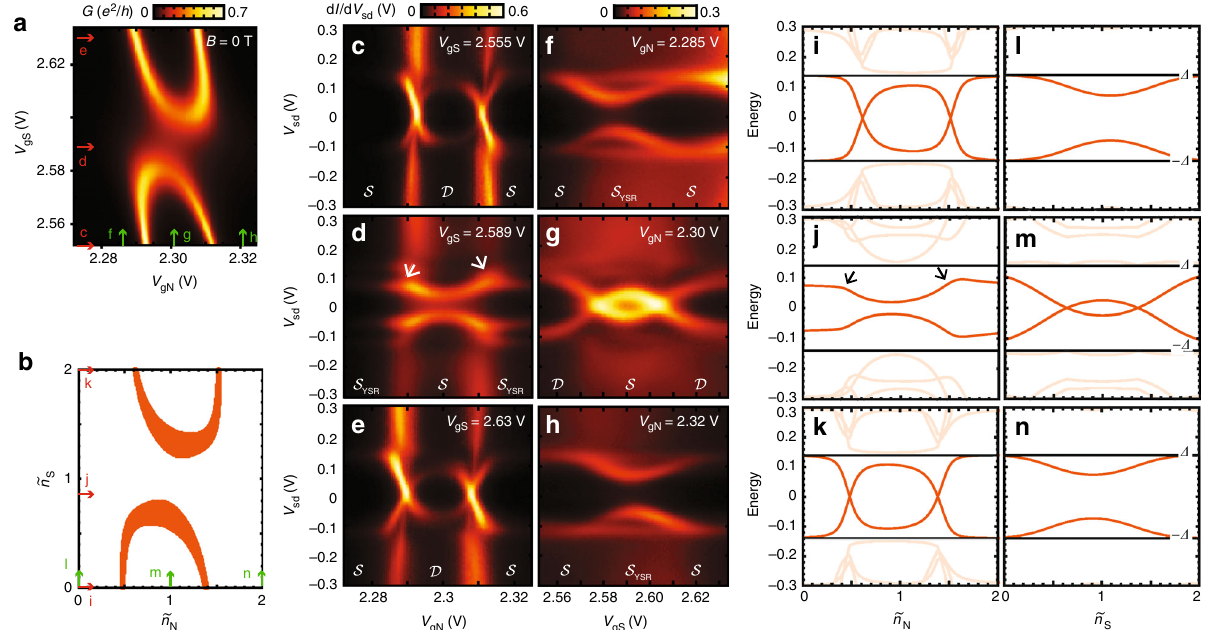
Fig. 3 Sub-gap states in the partly screened regime. a Stability diagram showing linear N-DQD-S conductance vs. plunger gates at T = 30 mK. b DQD-S zero-bandwidth model reproducing the experimental behavior in a for intermediate coupling t S to S. Orange regions marking ground state transitions have singlet-doublet splitting less than 0.015 meV. c – e Bias spectroscopy of sub-gap states vs. QD N occupation, sweeping V arrows in a . f – h Sub-gap spectroscopy vs. QD S occupation sweeping along green arrows in a . All plots show clear sub-gap resonances consistent with the ground states (doublet D or singlet S ) for different gate voltages indicated below. i – n Zero-bandwidth model calculation of sub-gap excitations corresponding to experimental plots c – h . Parameters used in b, i – n are (meV): U N = 2.5, U S = 0.8, U D = 0.1, t d = 0.27, t S = 0.22, and Δ = 0.14. Additional data related to the partly screened regime and how the above parameters are extracted from experimental data can be found in the Supplementary Note 2, Device